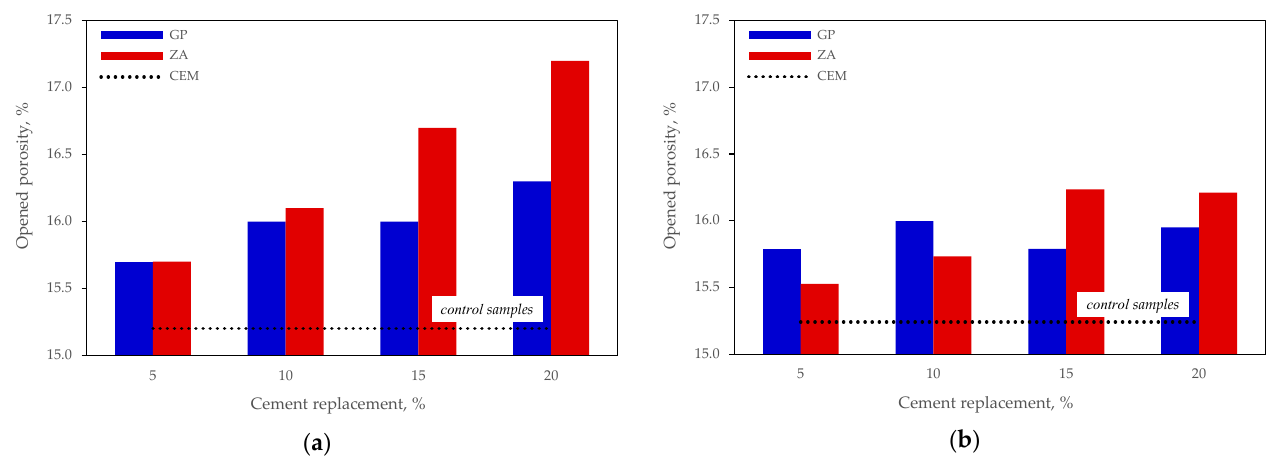
Figure 9. Open porosity of mortars No 1: ( a ) after 28 days; ( b ) after 90 days. However, it should be noted that a small decrease in the open porosity was observed in the specimens containing 15% glass powder. Although after 90 days of curing the porosity difference decreased, the modified specimens demonstrated higher open porosity results than control specimens. After 90 days of curing, a slight decrease in porosity values was again observed in the specimens containing 15% glass powder.